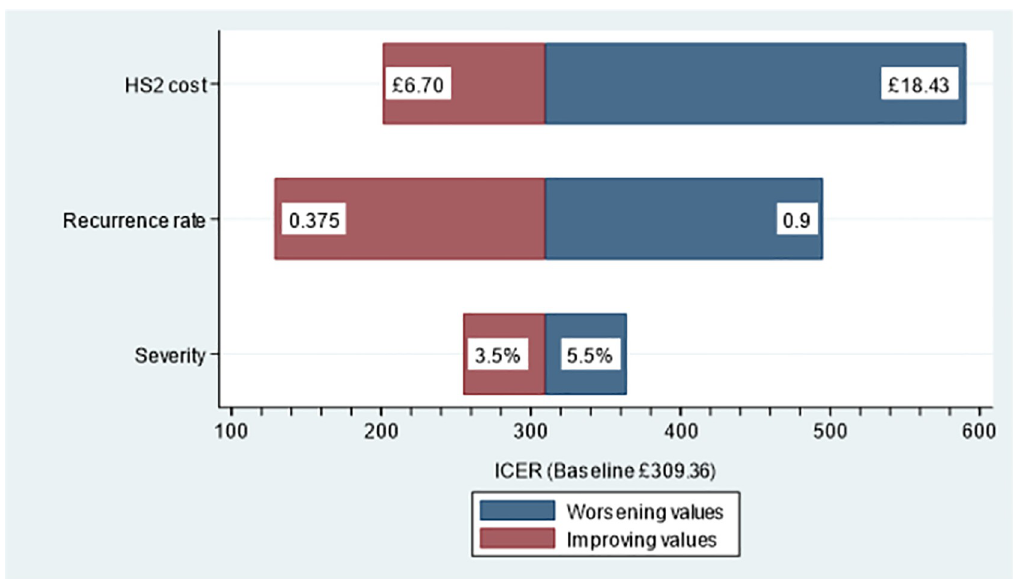
Fig 3. Tornado diagram for selected sensitivity analyses. One-way sensitivities of baseline ICER due to low/high variations: (i) HS2 intervention cost (+£6.70 to +£18.43; baseline £9.95), (ii) Hypoglycaemia recurrence rate r 0.75), (iii) Severe recurrent hypoglycaemia rate (3.5% to 5.5%; baseline